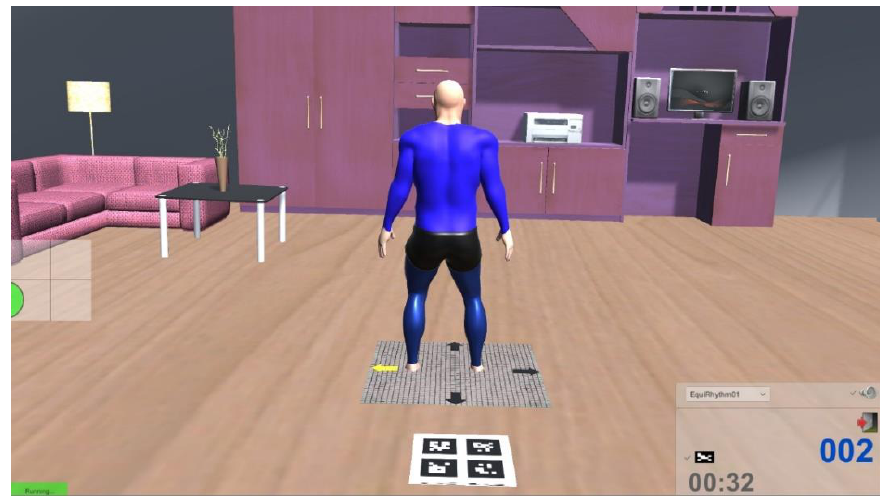
Figure 4. Illustration of the training game “Dancing”, where at the stage the user is asked to perform directional weight transfers according to the indications given by the yellow arrow.